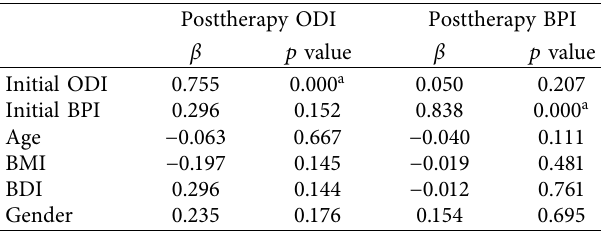
Table 5: Association between various factors associated with posttherapy ODI and